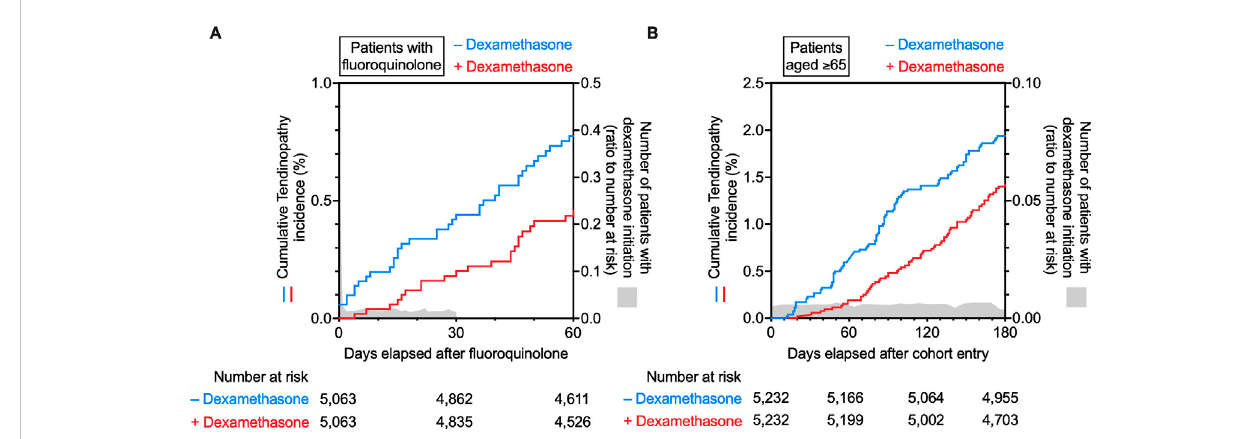
FIGURE 3 Time trends in the incidence of tendinopathy in the fl uoroquinolone-prescribed or older adult cohort in the IBM MarketScan data. Kaplan – Meier curves for the cumulative incidence ratio of tendinopathy in patients taking fl uoroquinolone (A) or patients aged ≥ 65 years (B) are shown individually as twopopulations:onewithout(blue)andonewith(red)co-prescribeddexamethasone.Thenumberofpatientswithdexamethasoneinitiationisshownin gray as a ratio to the number at